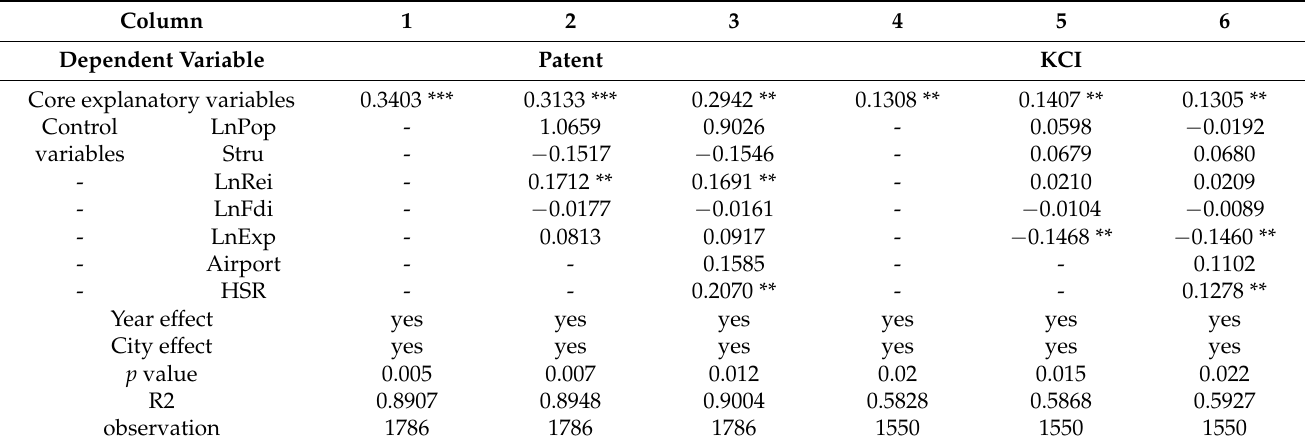
Table 3. Estimation results (universal impact).